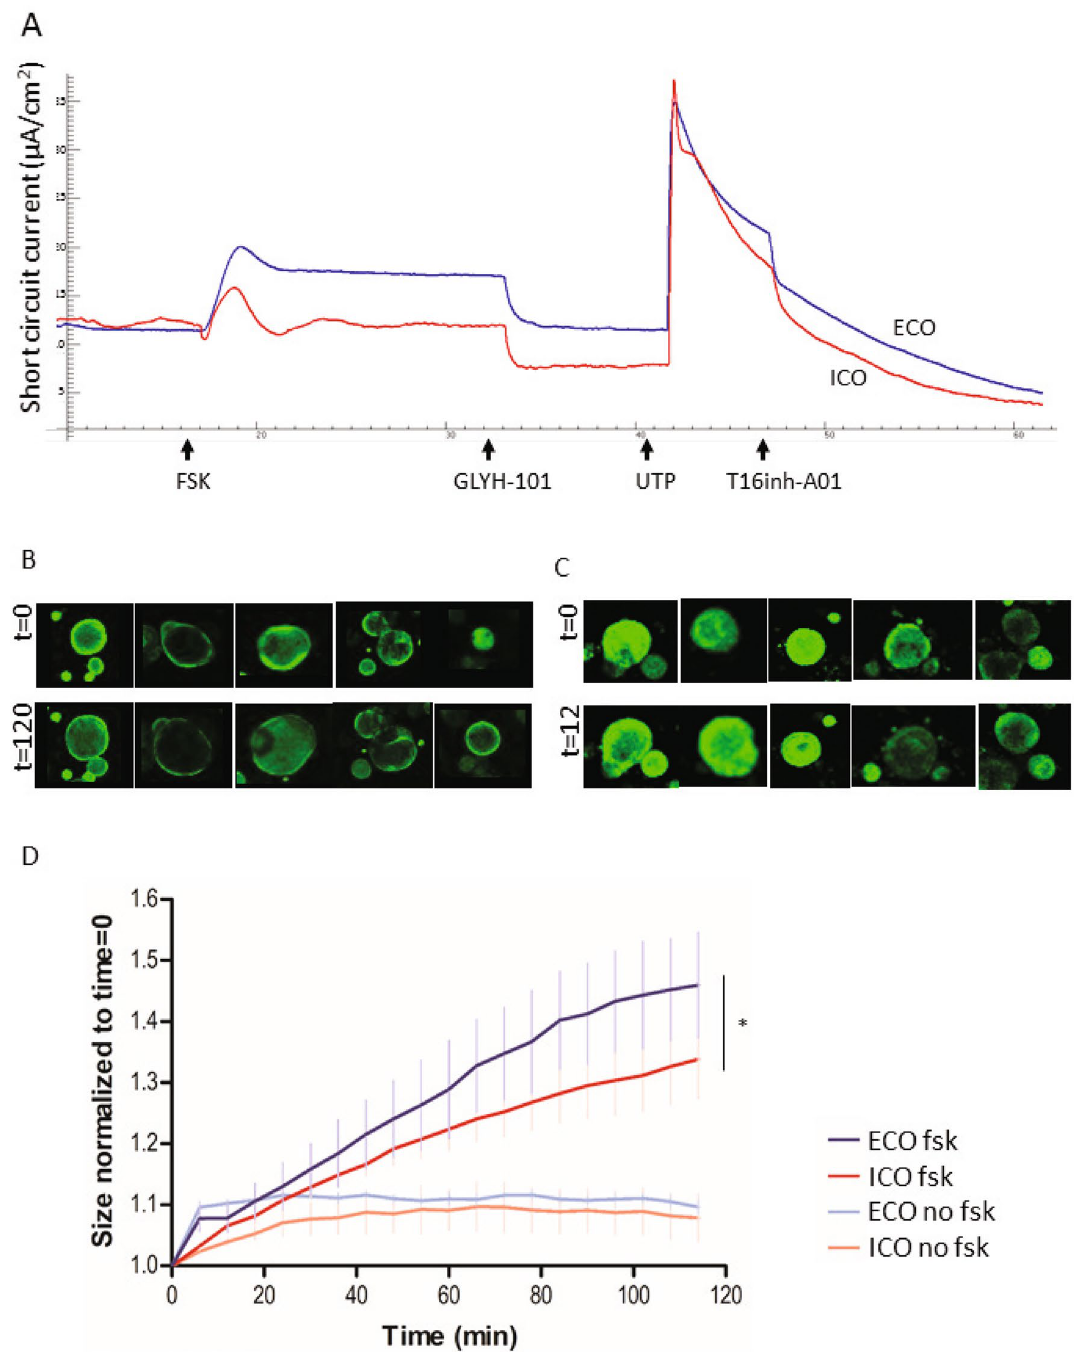
Figure 3. Forskolin-induced ion channel activity is more prominent in ECO then ICO. A representative Ussing experiment ( A ) shows CFTR stimulation by forskolin (FSK, 5 μM) in ECO (blue line) and ICO (red line) organoids. GlyH-101 inhibits the CFTR transporter channel specifically. Ca 2+ -activated Cl-channels (CaCC) are stimulated by UTP and inhibited by CaCC inhibitor T16inh-A01 (arrows) demonstrating the presence of functional CFTR and Ca 2+ -activated Cl-channels in these organoids. Functionality of CFTR in 3D grown organoids was shown by FIS. Representative pictures of five individual calcein green-labeled ECO ( B ) and ICO ( C ) before (t = 0) and after (t = 120) forskolin stimulation show the swelling in time. Qualification of organoid size in time showed that ECO swell significantly larger upon forskolin-activation than ICO (D) (* p <